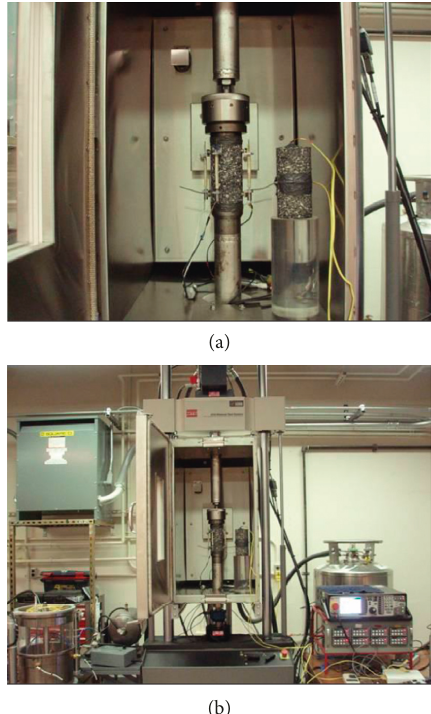
Figure 2: (a) Instrumented tension test specimen and (b) MTS